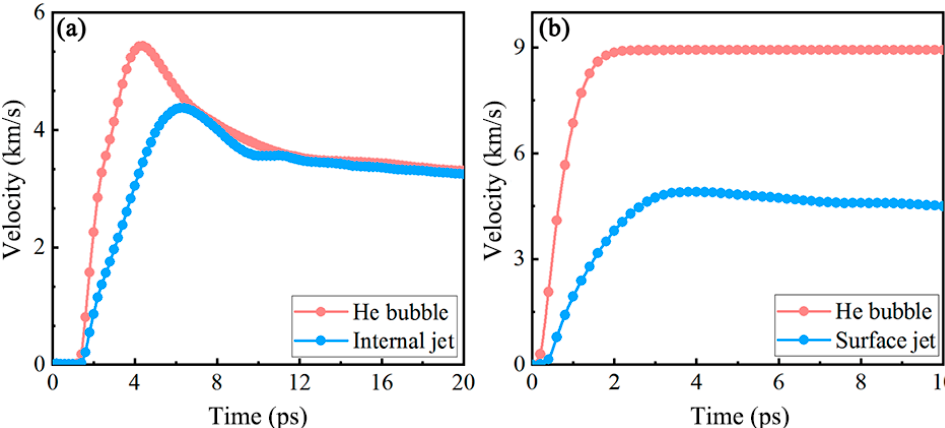
Figure 14. Comparisons of the average velocity evolution of the microjet and He bubble. ( a ) Internal jet; ( b ) Surface jet.